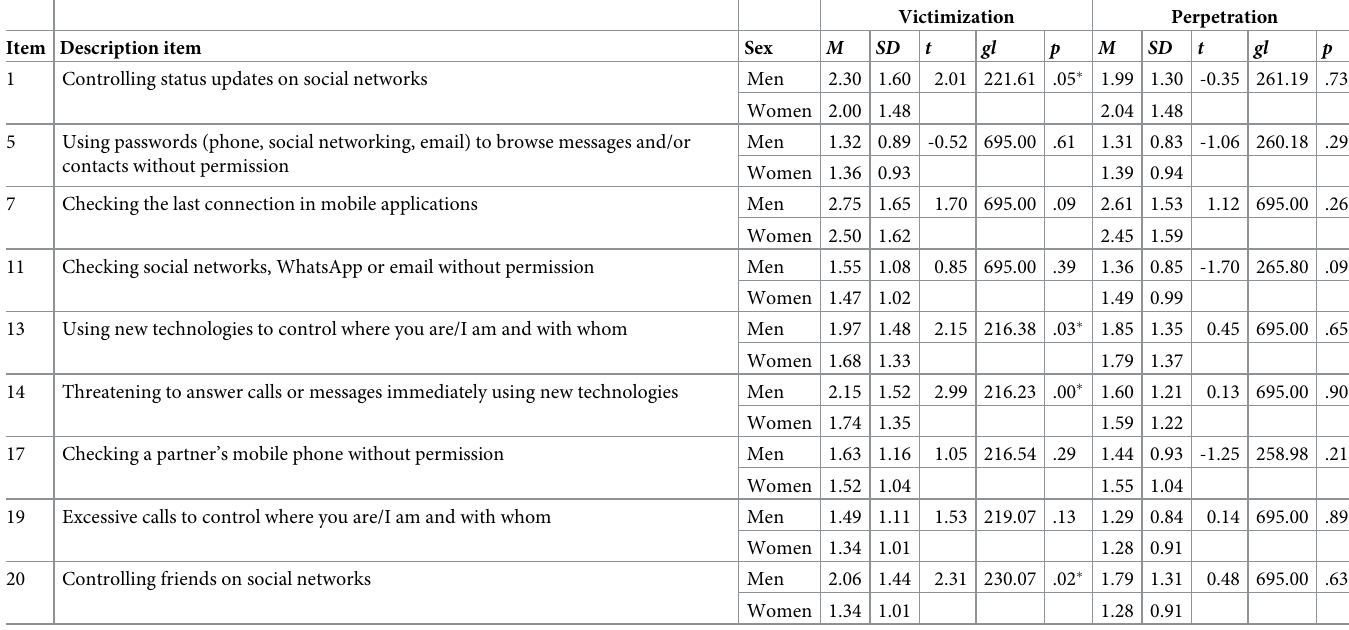
Table 5. Sex-related differences for each item of the cyber-control subscale, for both victimization and